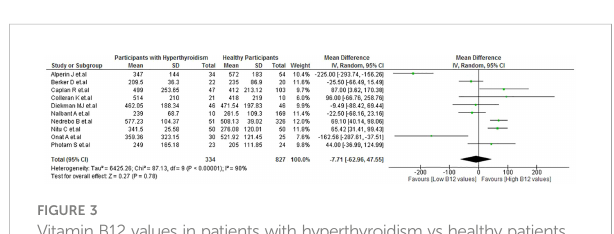
FIGURE 3 Vitamin B12 values in patients with hyperthyroidism vs healthy patients.